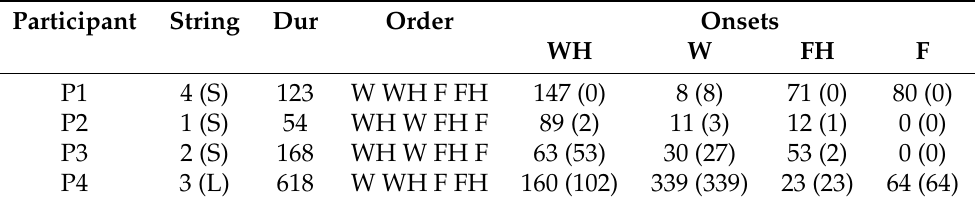
Table 3. Total number of onsets per condition (WH = wheelchair-haptics on, W = wheelchair-haptics off, FH = floor-haptics on, F = floor-haptics off), with onsets triggered by the student presented in brackets. String labels: L = large platform, S = small platform.